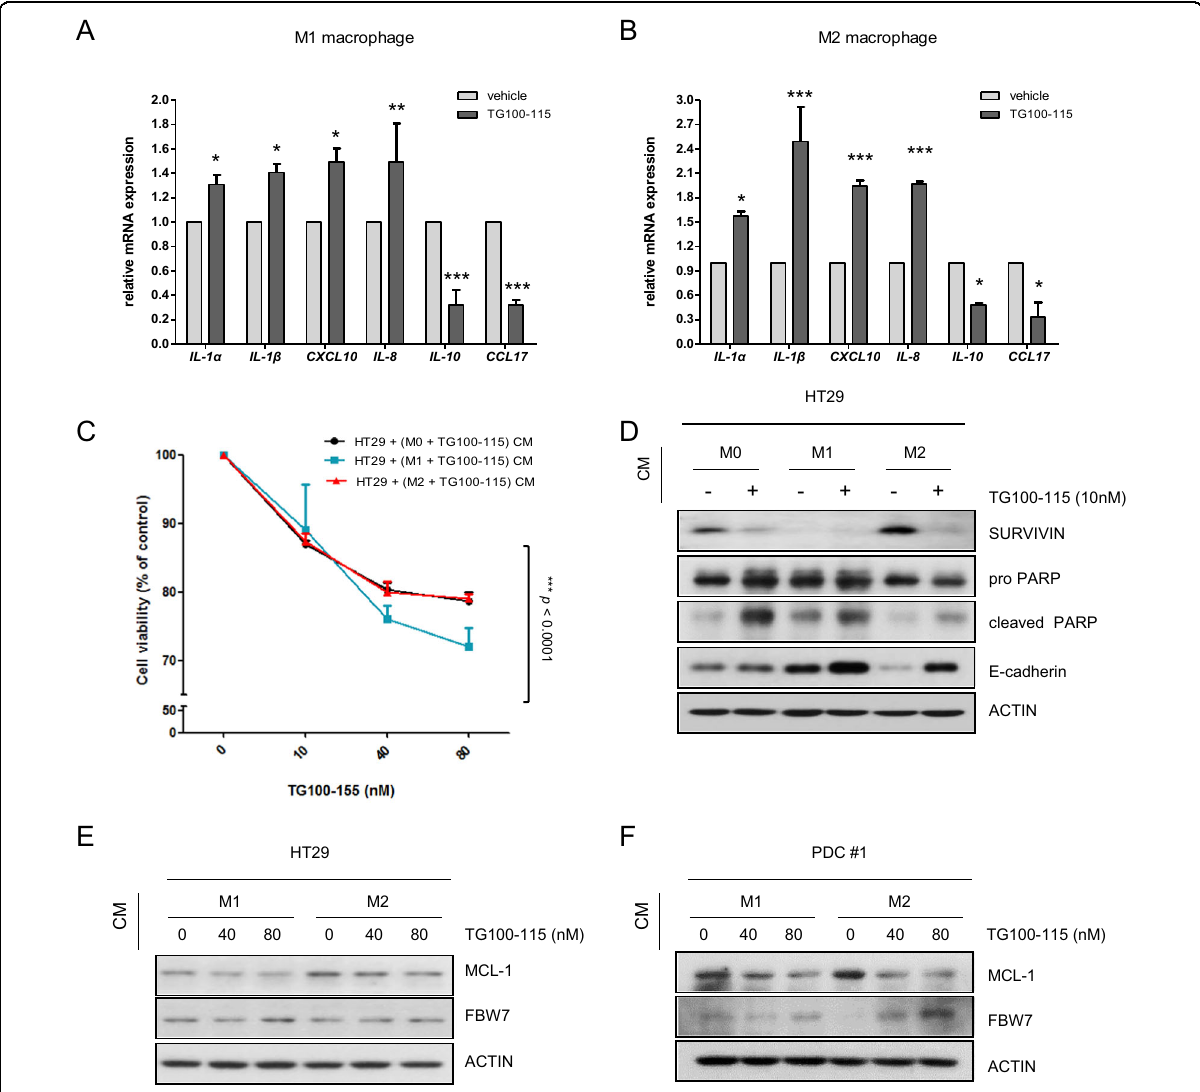
Fig. 6 Role of PI3K γ in TAM-mediated colon cancer cell viability and EMT characteristics. mRNA expression levels of genes involved in the proin fl ammatory response ( IL-1 α , IL-1 β , CXCL10 , and IL-8 ) and antiin fl ammatory response ( IL-10 and CCL17 ) were evaluated by real-time PCR in M1 a and M2 b macrophages with or without treatment with 10 n M TG100-115 (PI3K γ inhibitor) for 18 h. c HT29 cells were exposed to TG100-115-treated macrophage CM for 24 h. Cell viability was then measured by WST-1 assay. d Expression levels of apoptosis- and EMT-related markers in CM-treated HT29 cells. CMs were derived from TG100-115 (10 n M )-treated or untreated M0, M1, and M2 macrophages. HT29 cells e and PDCs f were incubated with TG100-115-treated macrophage CM for 24 h. Protein levels of MCL-1 and FBW7 were evaluated using western blotting. Actin was used as a loading control. The results are presented as the mean ± SE. * P < 0.05; ** P < 0.01; *** P <